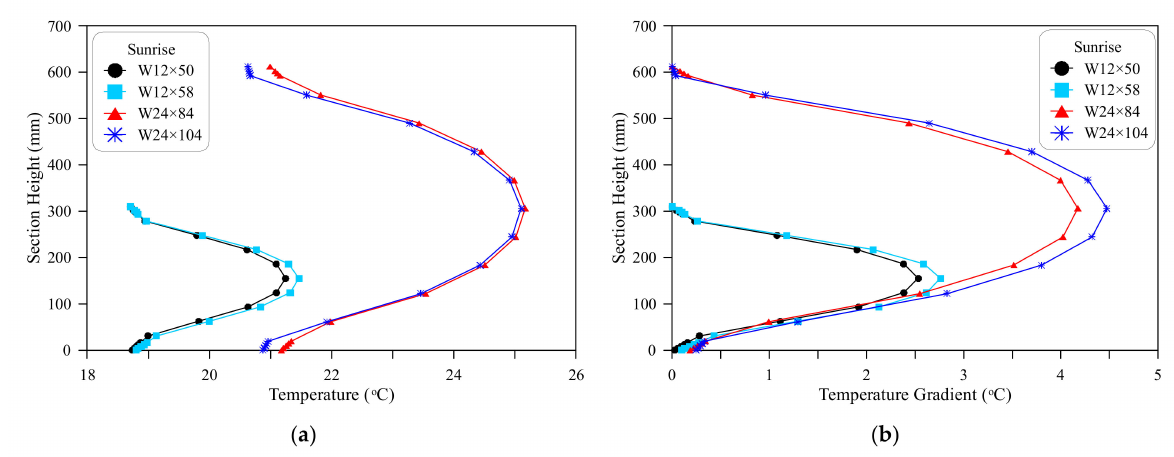
Figure 13. Vertical temperature distributions and temperature gradients at sunrise: ( a ) Temperature distributions; ( b ) Temperature gradients.